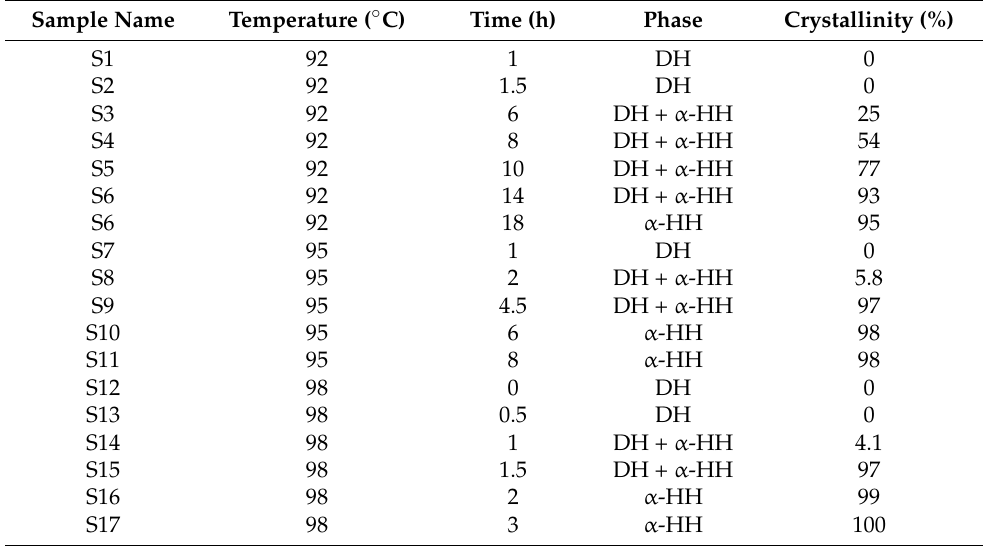
Table A1. Hydrothermal synthesis conditions and crystallinity of the α -HH